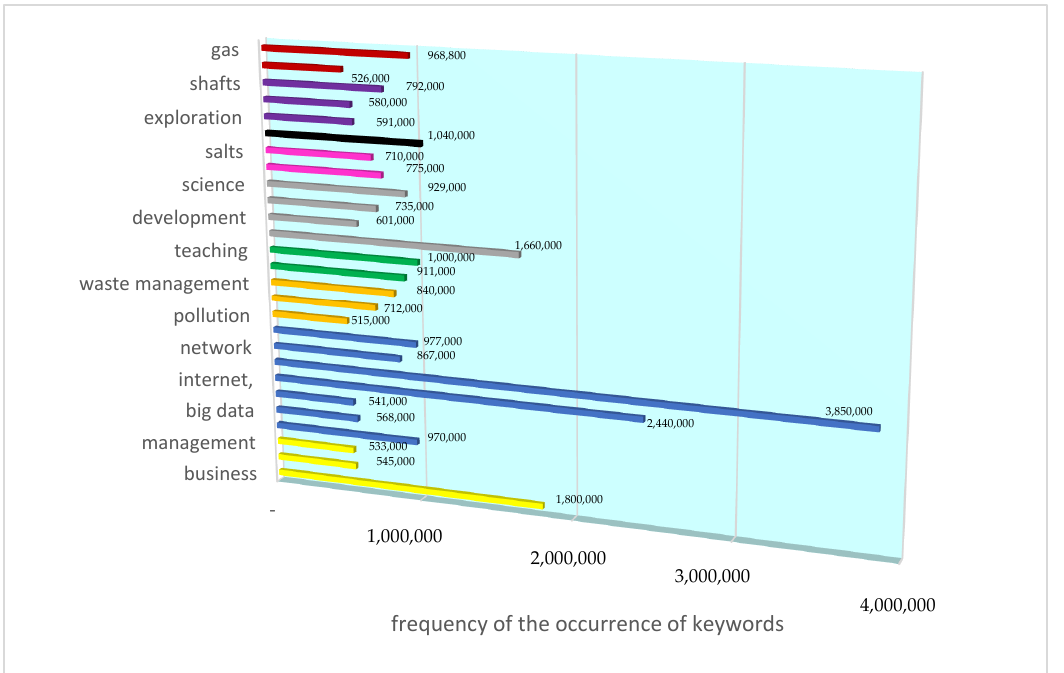
Figure 5. Assessment of the market attractiveness of industries related to the raw material industry. Source: authors’ own study based on [18].